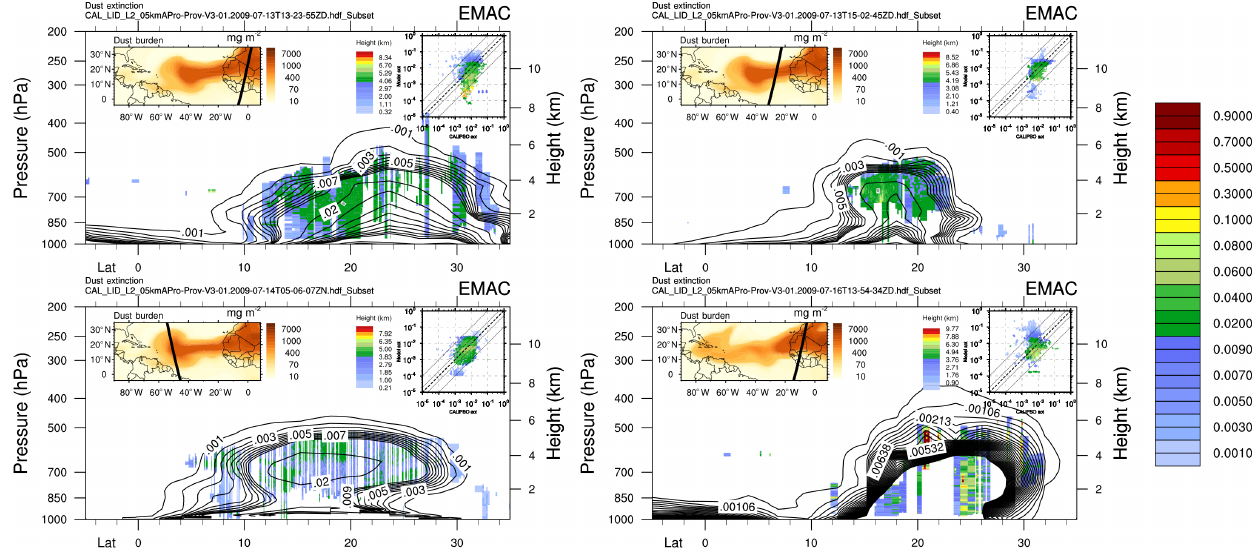
Figure 7. Collocated EMAC and CALIPSO observations of the dust extinction and burden for four different CALIPSO overpasses during the second dust outbreak over the Atlantic Ocean. The time of the overpass is shown in the upper left corners (13–16 July 2009). The solid lines show the simulated extinction, and the colored contours show the observed CALIPSO extinction, which is complemented by the scatter plots for a point-to-point comparison colored by the corresponding elevations of each observation (distinguished by the colors). The lines in the scatter plots delineate the 1-to-1, factor-2 and factor-10 intervals. All available comparisons with CALIPSO overpasses for this period are shown in the Supplement (Fig. S2a–e).